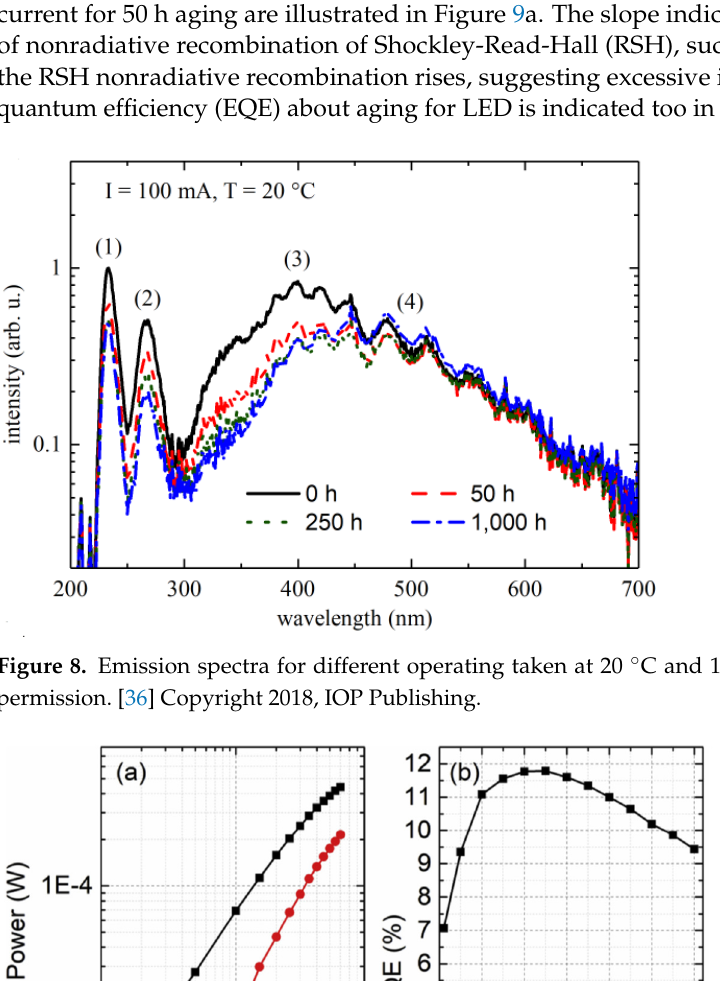
Figure 10. Spectrum variation during 500 mA stress test. Reproduced with permission. [48] Copy- right 2018, Elsevier. Pinos et al. studied the emission spectrum from a 285 nm AlGaN quantum well light- emitting diode (QW-LED). The results indicated that certain regions (which are microm- eter-sized, domain-like areas) having lower AlN molar fractions pour out light with higher intensity. Furthermore, the various experiments performed revealed that intensity from these regions raised with time and a redshift in wavelength is observed [49]. In an- other study, Pinos et al. described the degradation under the influence of elevated current stress of AlGaN quantum well-based LEDs pouring out light of 285 and 310 nm wave- length. The results revealed that elevated concentration of nitrogen-vacancy and tunnel- ing current as well as partial reimbursement of the p-doping caused to decrease in the emission intensity during the aging process [50]. Jan Ruschel et al. investigated the deg- radation in UV-LEDs for 1000 h of stress [51]. The influence of operation current within the range 50–300 mA was also studied in comparison to current densities in the particular range from 34 A/cm 2 to 201 A/cm 2 . In aging operations, the optical power reduction was robustly speed-up for higher current [52,53]. Matteo Meneghini et al. explored DUV-LEDs and analyzed the reliability at a DC stress of 20 mA. In response to aging, the devices intimated a lesser optical power [39].